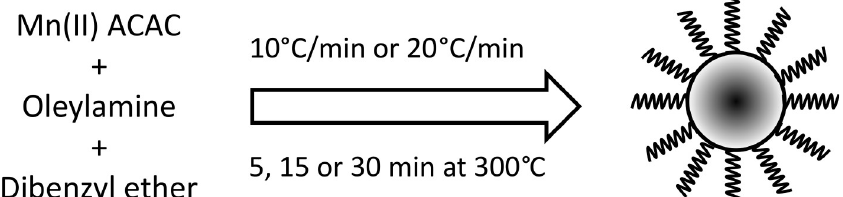
Fig 1. Thermal decomposition of Mn(II) ACAC was performed in oleylamine and dibenzyl ether at two temperature ramp rates and increasing aging times at 300˚C to form MnO NPs coated with